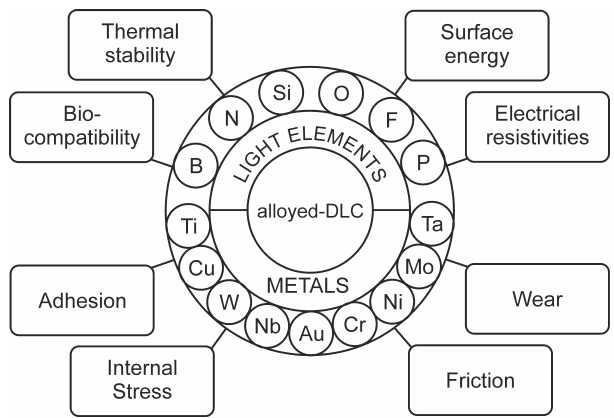
Figure 1. Scheme of proposed doping elements of DLC [13].